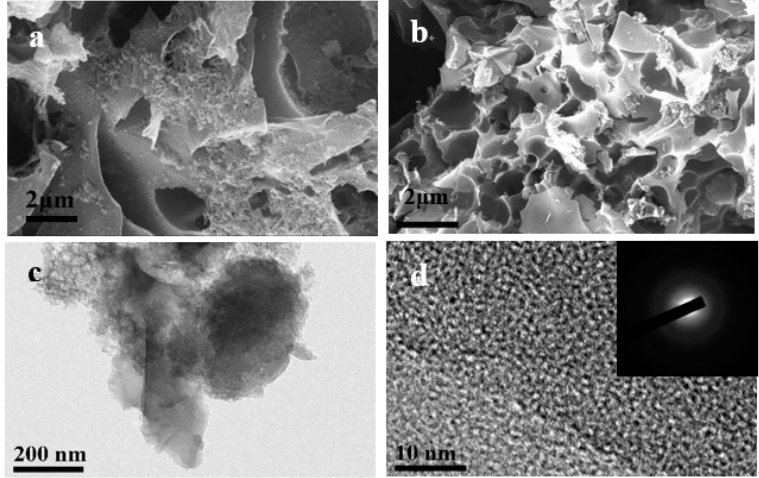
Figure 2. SEM images of ( a ) wool derived activated porous carbon (WAPC), ( b ) N ‐ doped wool derived activated porous carbon (N ‐ WAPC); TEM image ( c ) and ( d ) HRTEM image of N ‐ WAPC (inset: SAED).